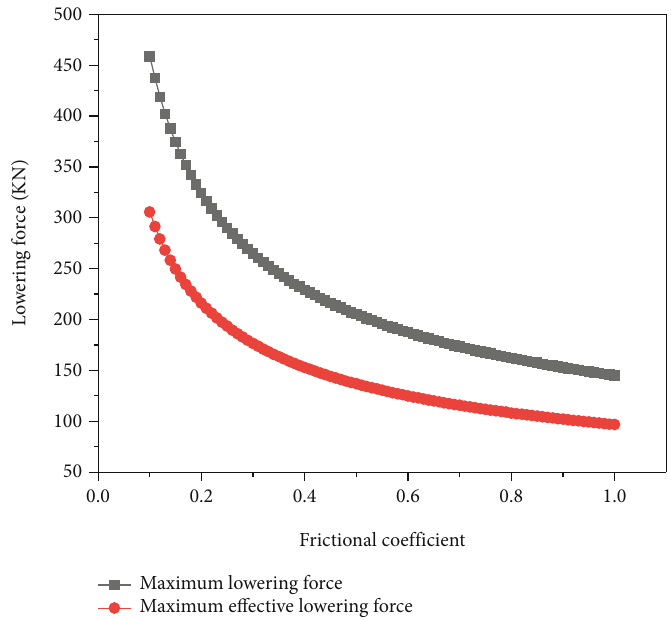
Figure 11: Lowering force on the casing string for di ff erent friction coe ffi cients.